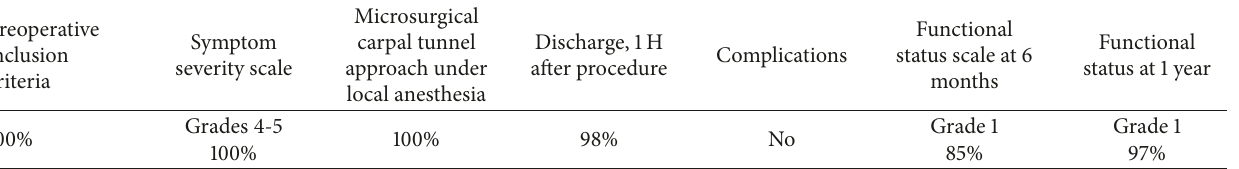
Table 1: Evaluation of cases at long term with the functional status scale in daily activities.